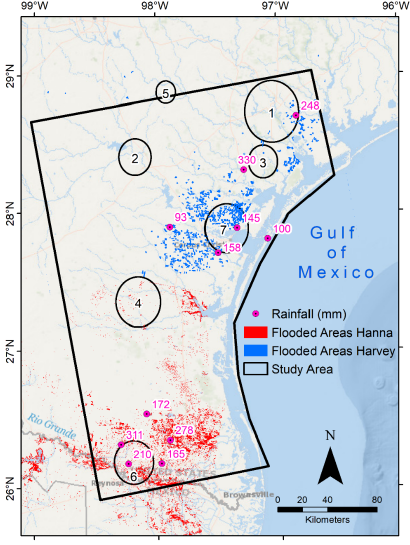
Figure 7. Areas inundated after Hurricane Harvey (blue polygons) and Hurricane Hanna (red polygons). Rainfall amounts (in mm), extracted from National Oceanic and Atmospheric Administration (NOAA) rain gauges (purple dots), during these events are also shown.